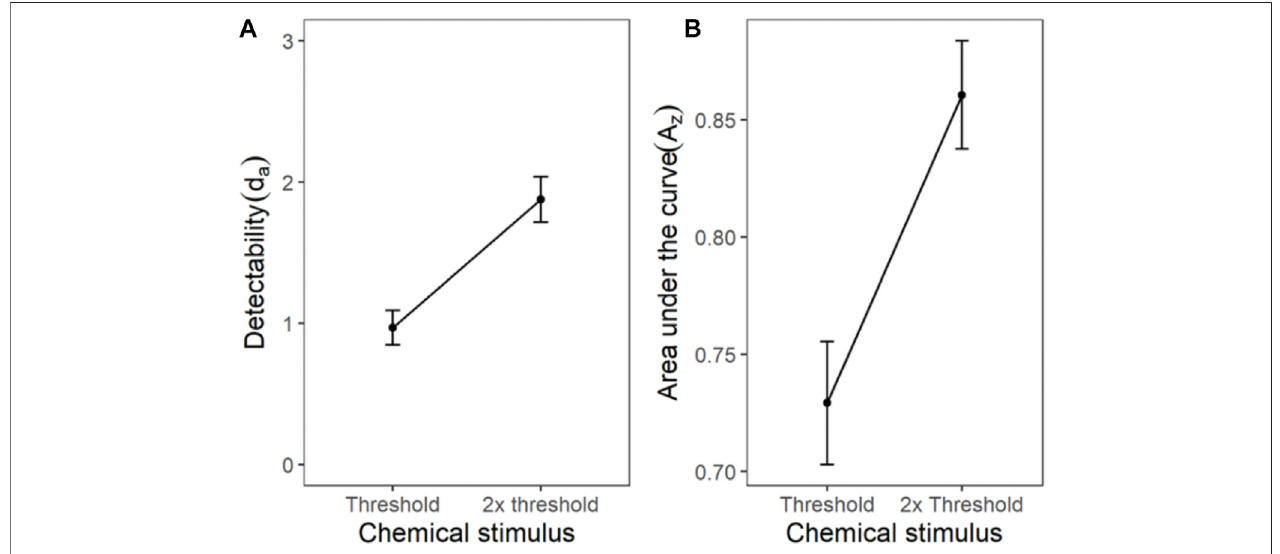
FIGURE7| Thetransducerfunctionford a andA z ofchemicalthresholdand2xthresholdstimuli.Eachhorizontalaxisisstimulusintensityandintheleft-handpanel, the y -axis is detectability (d a ) and in the right-hand panel, the y -axis is area under the curve (A z ). The points are the means and error bars are the SE of the